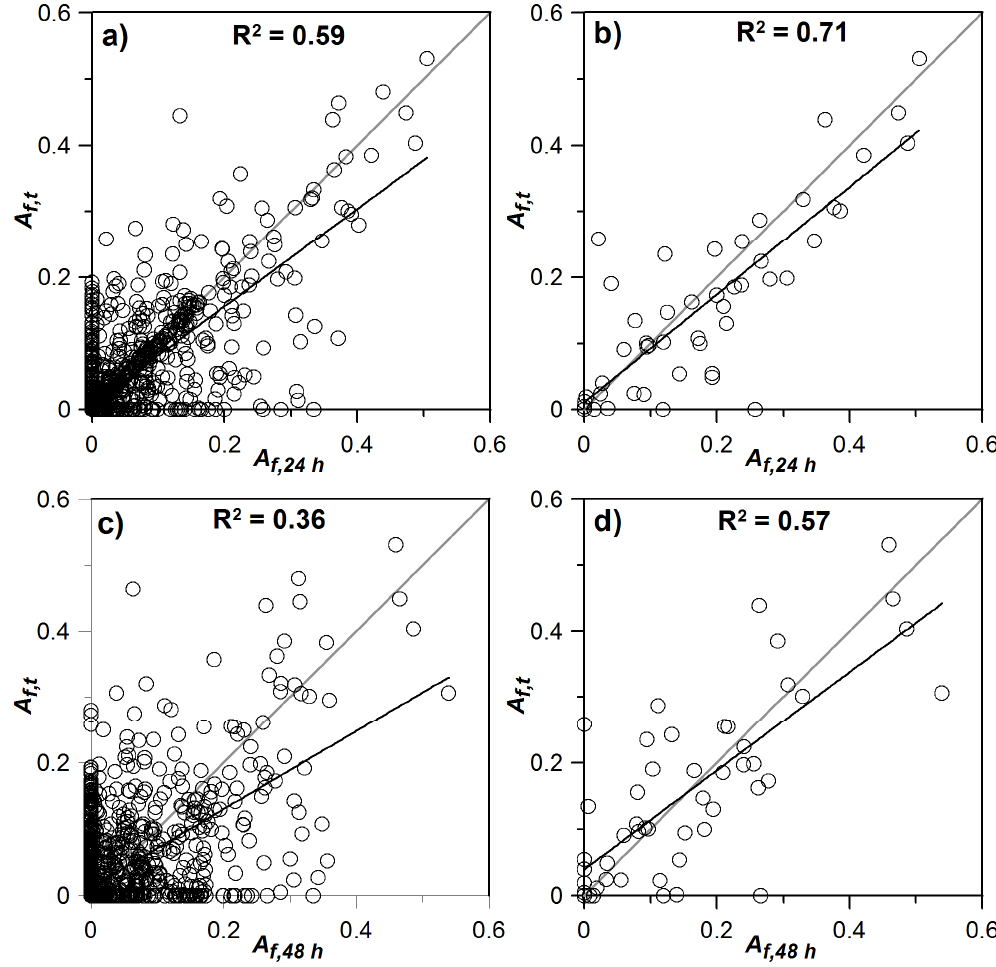
-values) predicted using observed Figure 8. Correlation of saturated fractional areas ( A f ) versus A -values predicted with 24 h ( A ) forecasted ( a , b ) and weather data ( A f , t f f ,24 h ) forecasted weather data ( c , d ). Plots ( a ) and ( c ) compare A -values on a daily 48 h ( A f ,48 h f basis for the entire record period. Plots ( b ) and ( d ) show the correlations for storm events with observed discharges greater than 5 mm·day − 1 . Grey lines indicate the 1:1 relationship and black lines show fits of a simple linear